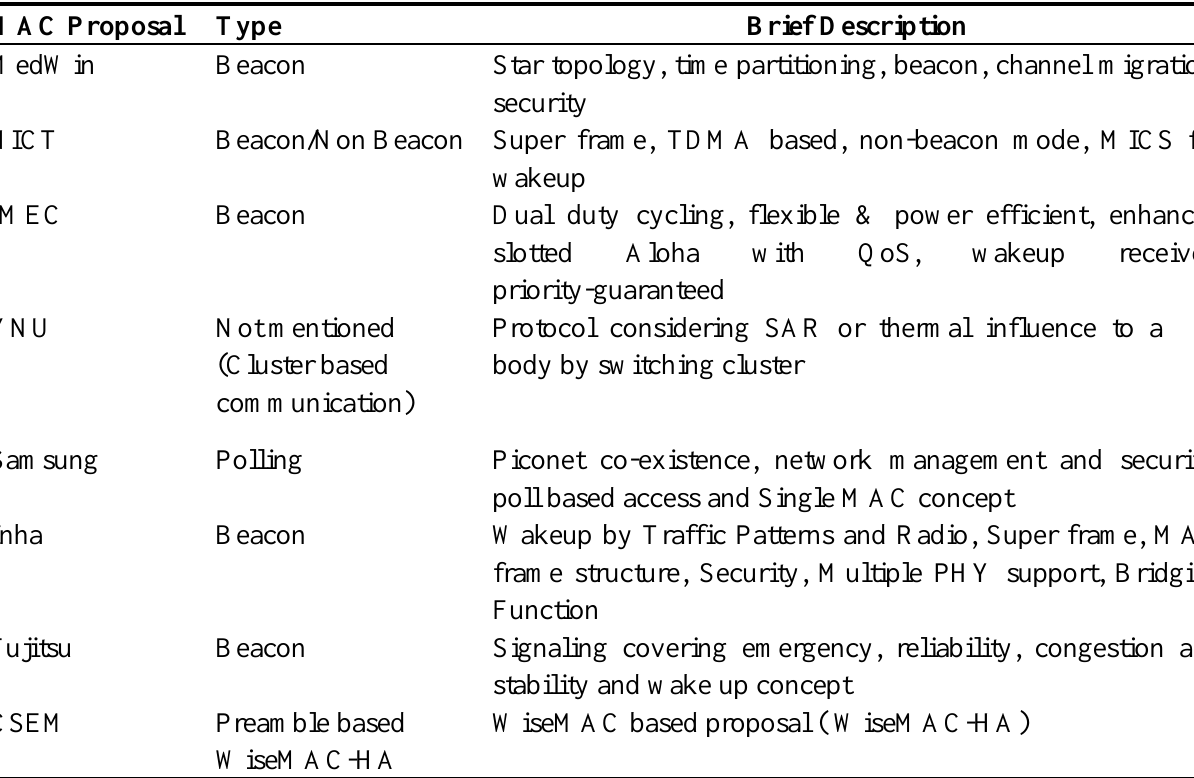
Table 3. MAC proposals for IEEE